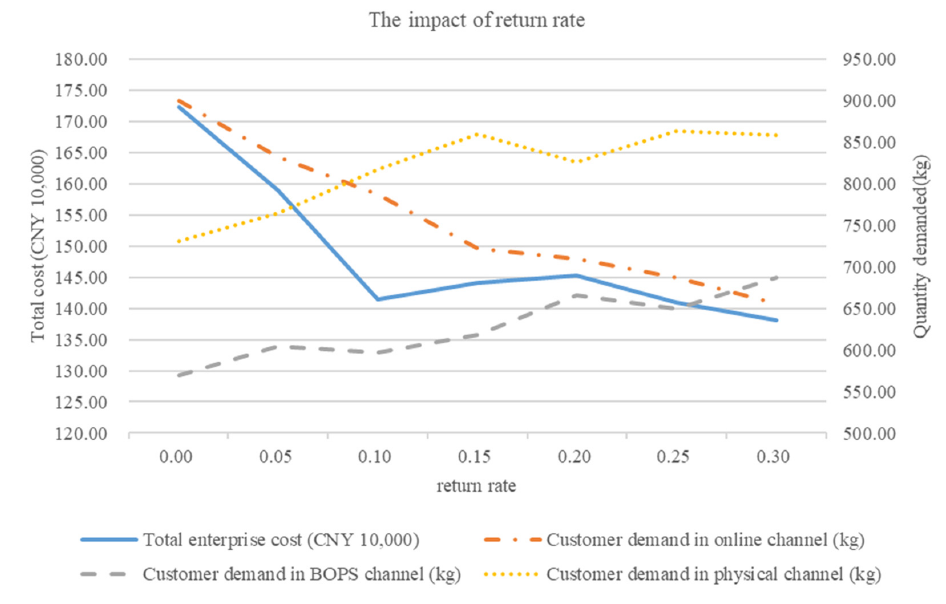
Figure 5. Sensitivity analysis of return rate.